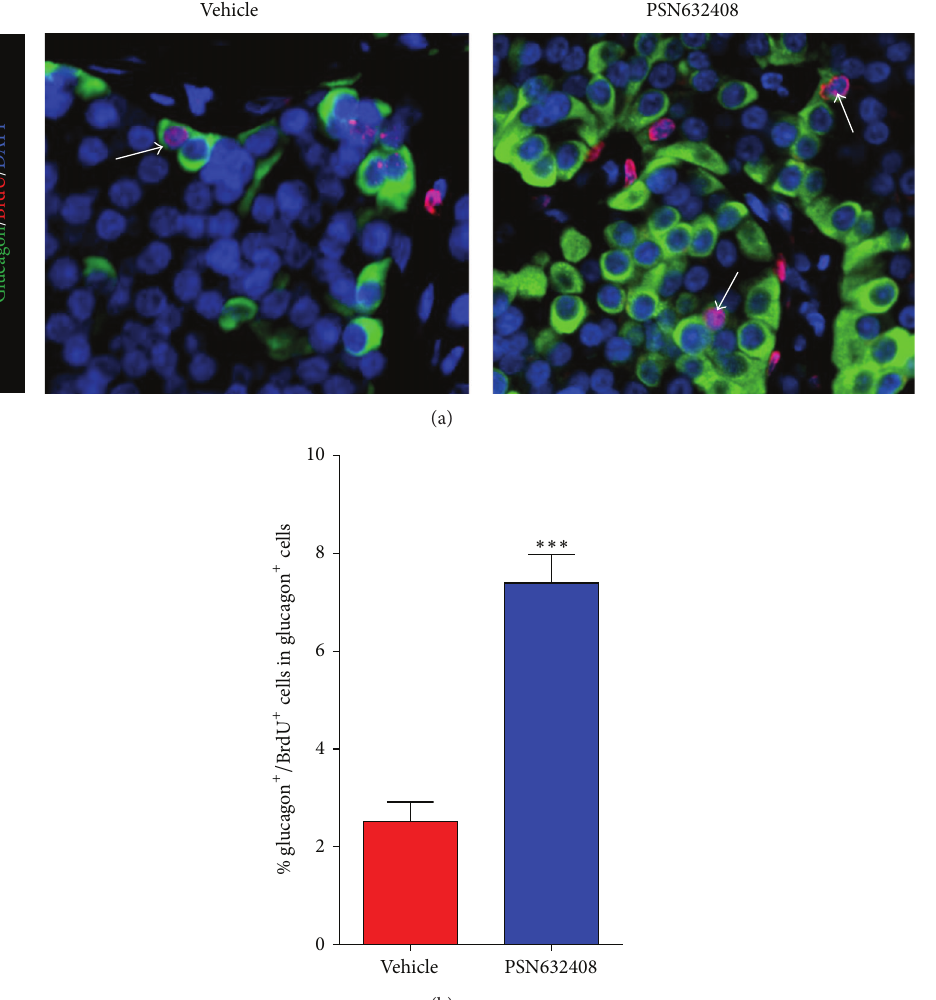
Figure 8: (a) Immunofluorescent staining for glucagon (green color), BrdU (red color), and DAPI (blue color) in human islet grafts from PSN632408- and vehicle-treated mice with normoglycaemia at 4 weeks after transplantation. White arrows show glucagon/BrdU copositive cells in human islet grafts. (b) Percentage of glucagon/BrdU copositive cells among total glucagon positive cells in human islet grafts. The average percent of glucagon/BrdU copositive cells among total glucagon positive cells was significantly higher in PSN632408-treated mice ( 𝑛 = 9 ) compared with vehicle-treated mice ( 𝑛 = 4 ) ( ∗∗∗ 𝑃 < 0.001